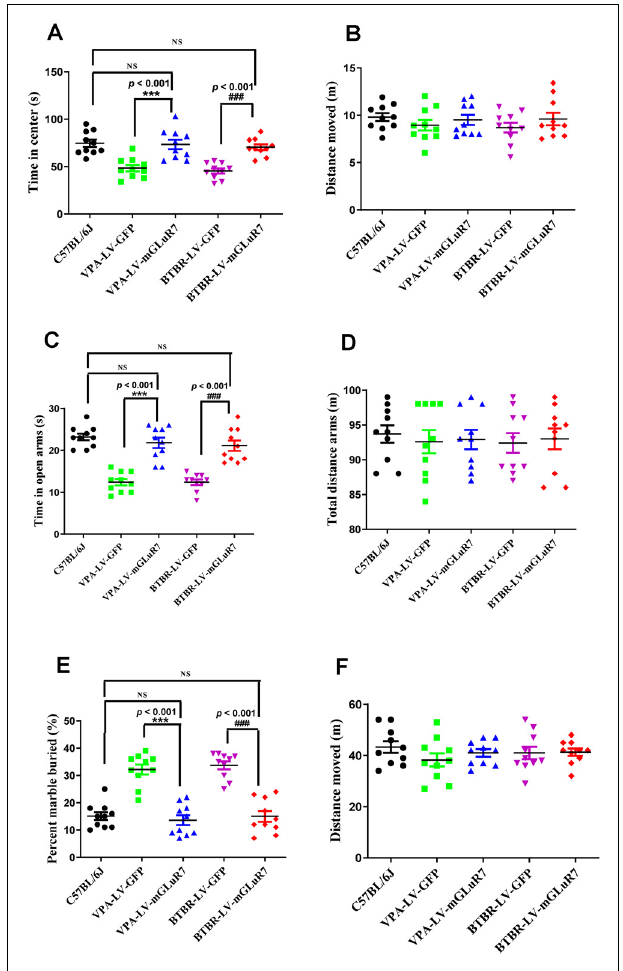
FIGURE 4 | mGluR7 overexpression alleviates anxiety-like and stereotyped/repetitive behaviors. (A,B) The overexpression of mGluR7 in VPA-treated and BTBR mice increased the duration spent in the central area in an open field test to a similar extent as that observed in C57B6L/J